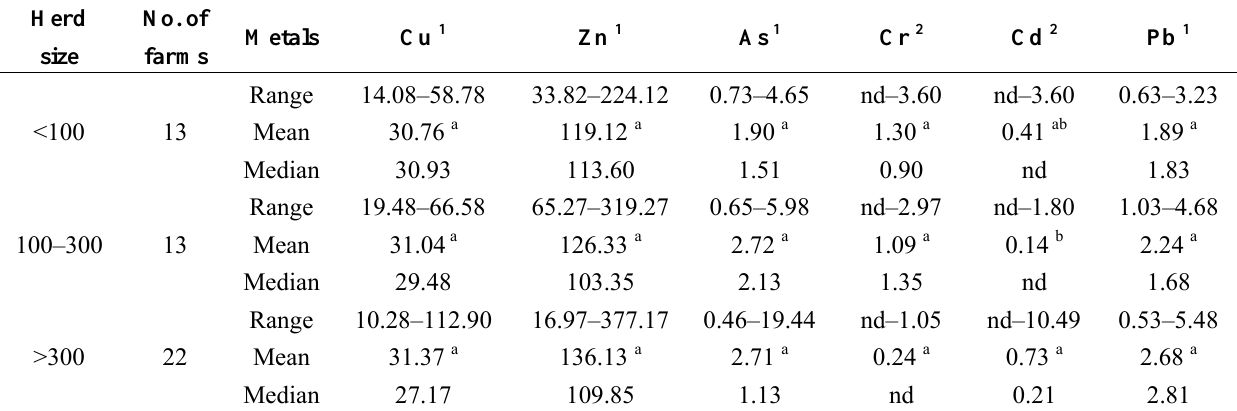
nd: non-detectable. Different letters (superscripts) in the same column indicate the signi fi cant difference between the mean contents of different farms ( p < 0.05) by 1 Tukey test and 2 Kruskal-Wallis